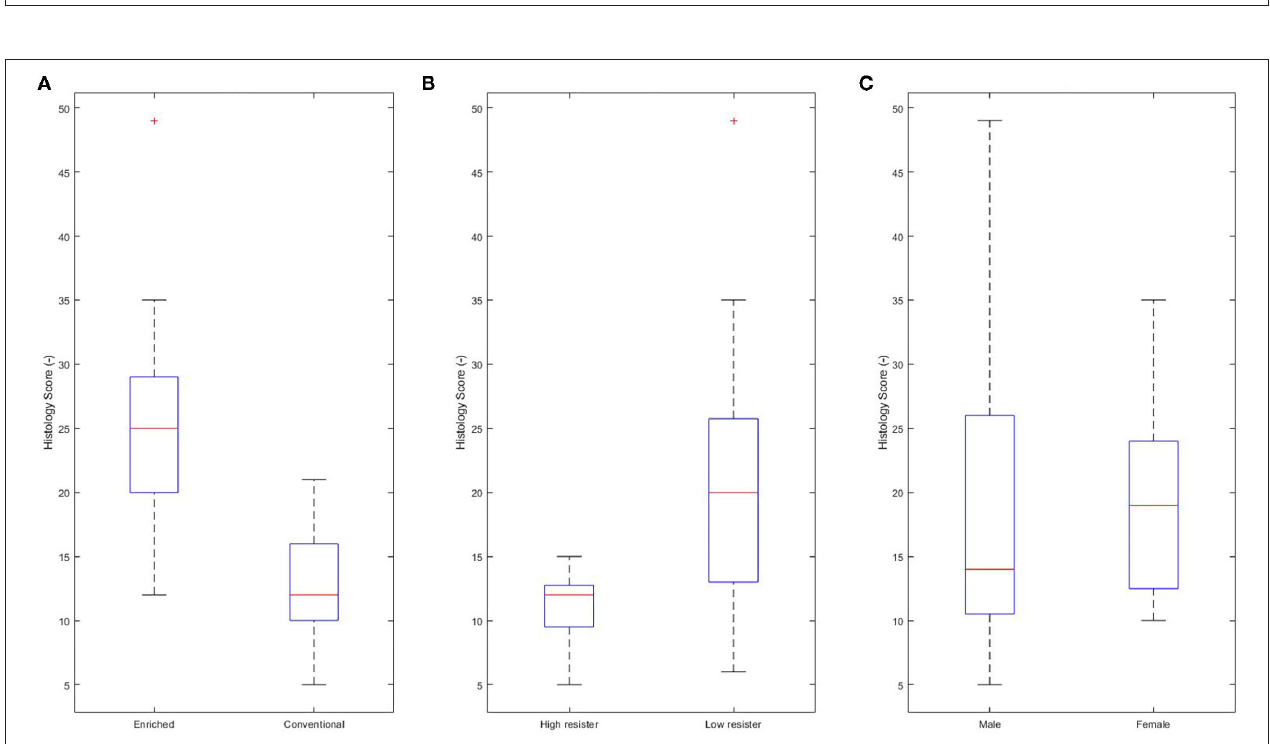
FIGURE 5 | Main effect of experimental variables on histology score. (A) Housing ( p < 0.05). (B) Coping strategy ( p < 0.05). (C) Sex not significant (NS).